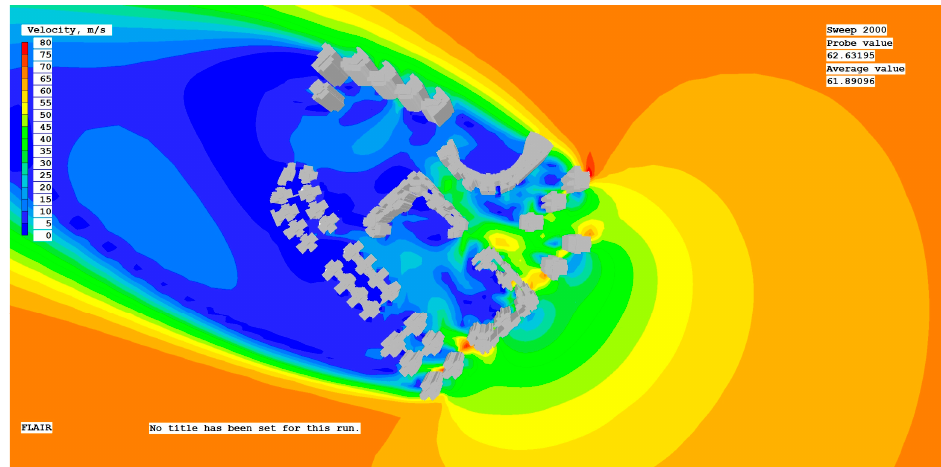
Figure A19. Wind speed distribution under typhoon conditions (100 m height).